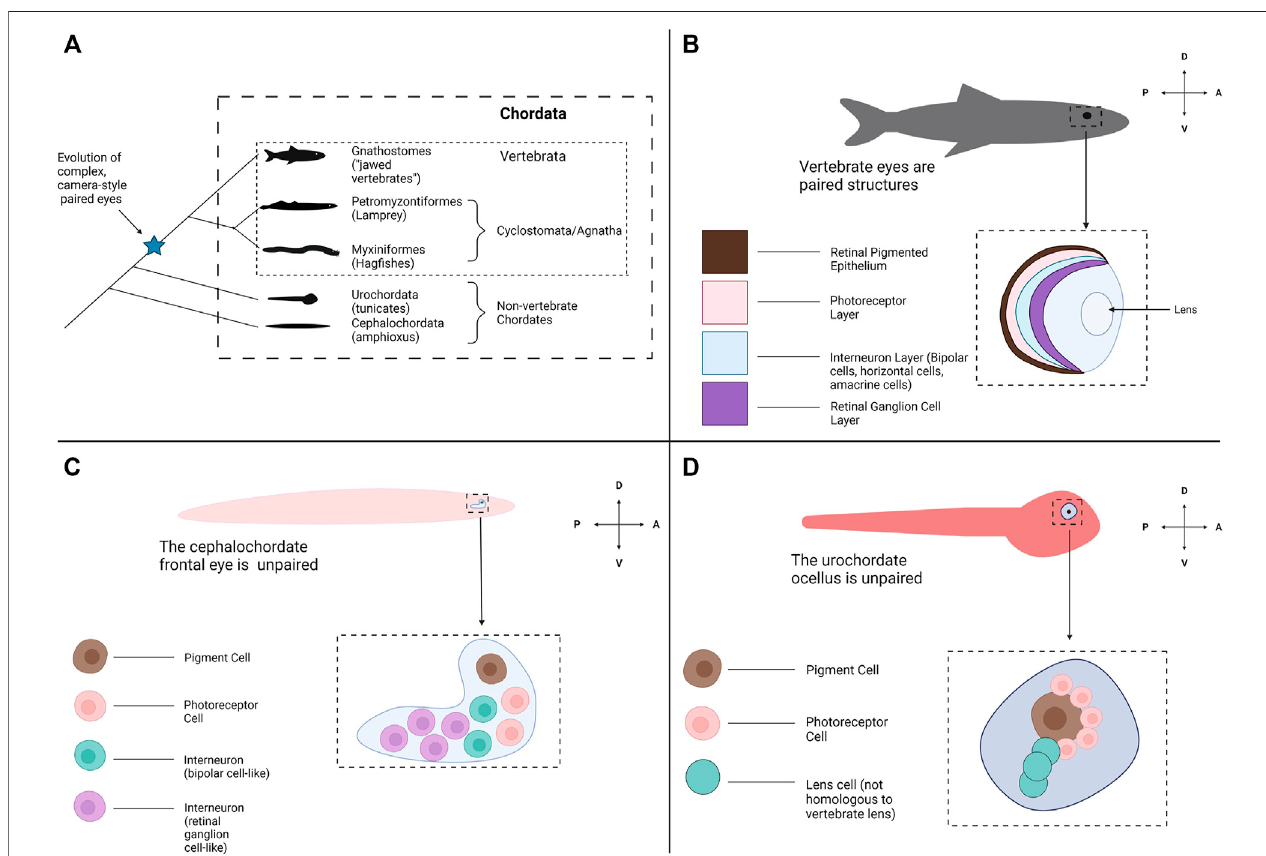
FIGURE1| EvolutionaryoriginsofthevertebrateeyeandtheappearanceofotherphotoreceptiveorgansacrossChordata. (A) AphylogenyofChordata.Chordata consists of three subphyla: Cephalochordata (amphioxus), Urochordata (tunicates) and Vertebrata (the Vertebrates). Two clades form Vertebrata: the Hag fi sh and Lamprey (Myxiniformes and Petromyzontiformes) form a distinct group known as Cyclostomata (extant members of the jawless vertebrates (Agnatha)) and the jawed vertebrates form Gnathostomata. Paired, complex eyes appear within Vertebrata but not in the other Chordate subphyla. (B) Most all gnathostomes have the familiar vertebrate eye and retinal structures, conserved from fi sh through mammals. The eyes are paired and bilateral. Each eye contains a multi-layered retina for light detection and imageformation, a pigmented retinal epitheliallayerand alensto focusincominglight. (C) Theamphioxusfrontal eye isan unpaired photoreceptive organ located at the anterior end of the amphioxus. The frontal eye contains a single pigment cell, several photoreceptor cells, and several interneurons (Vopalensky et al., 2012). (D) The tunicate ocellus is an unpaired photoreceptive organ that consists of a large pigment cell and associated photoreceptor cells (Horie et al., 2005).In some species the ocellus also contains lens cells, but these are not believed to be homologous with the lens structure of the vertebrate eye. Graphics created using BioRender.com.